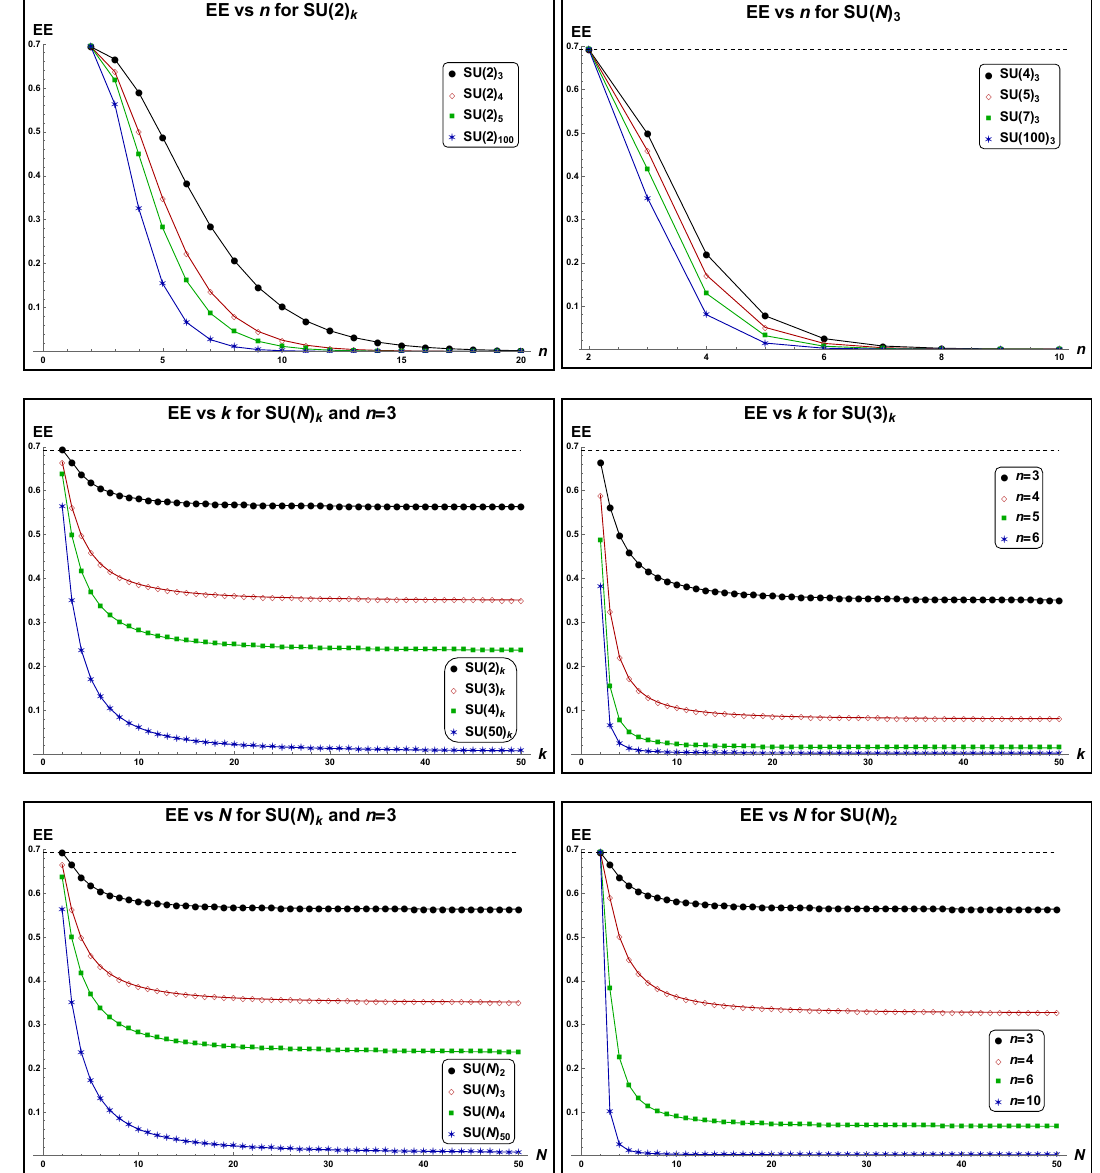
Figure 9 . The variation of SU( N ) k entanglement entropy for the state j (cid:9) lines carry fundamental representation. The horizontal dotted line corresponds to EE = ln 2 which is the maximum possible value for